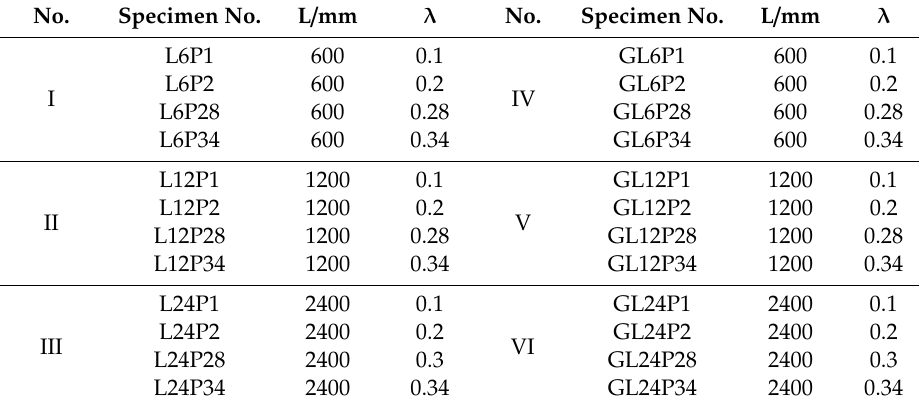
Table 1. Specimen